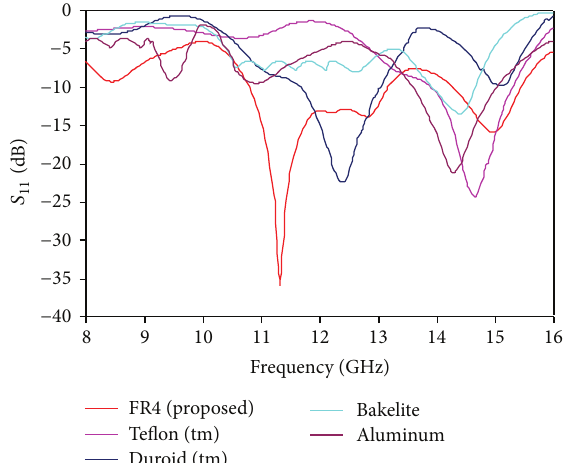
Figure 5: Reflection coefficient with different values of radius, 𝑅